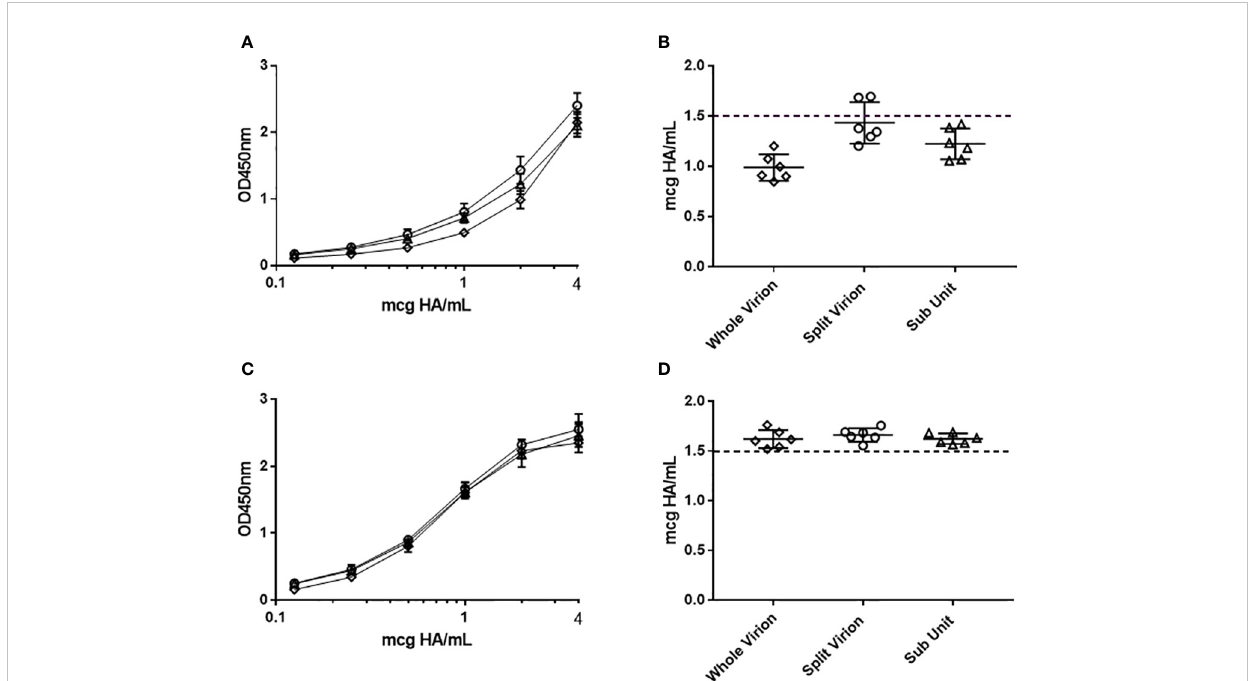
FIGURE 2 Assessment of the ELISA capture – detection method to analyse whole (diamond), split virion (circle) and sub-unit (triangle) antigen presentations. The assay was performed without (A, B) and with (C, D) sample pre-treatment using 0.5%(w/v) zwittergent 3-14 as described. Serial titration of antigen with average OD450nm responses are pictured (A, C) together with corresponding potency calculated from RA (B, D) . Error bars indicate standard deviation between replicate OD450nm raw data (A, C) and standard deviation of corresponding ELISA potency replicates (B, D)